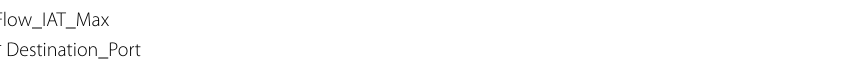
Table 12 Features appearing in at 7 out of 7 rankings of CSE-CIC-IDS2018,